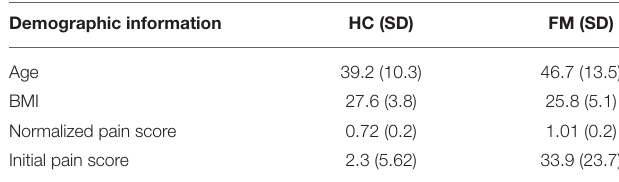
TABLE 1 | Demographic information for the healthy control (HC) and fibromyalgia (FM) groups. Where applicable the mean score is given, followed by the standard deviation in parentheses. The normalized pain score was calculated by dividing each individual’s average pain rating by the average stimulus temperature needed to elicit that rating. A higher number indicates higher pain sensitivity. The participant groups had significantly different scores on all four measures.